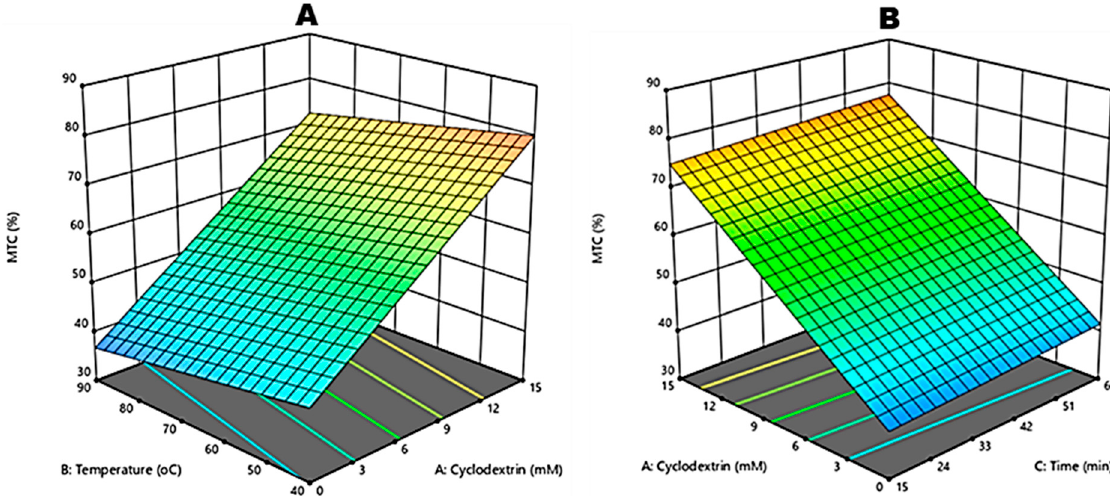
Figure 4. Response surface plots for independent variables for metal chelation (MTC) of crude green rooibos extracts: effect of Beta-cyclodextrin and reaction temperature ( A ) and the effect of Beta-cyclodextrin and reaction time ( B ).